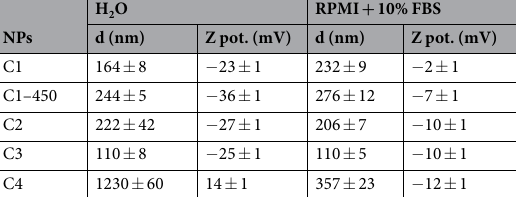
Table 2. Summary of DLS and zeta potential results for the tested CNPs. d: average hydrodynamic diameter ± standard deviation over three measurements obtained by cumulant analysis. Z_pot: zeta potential average ± standard deviation over three